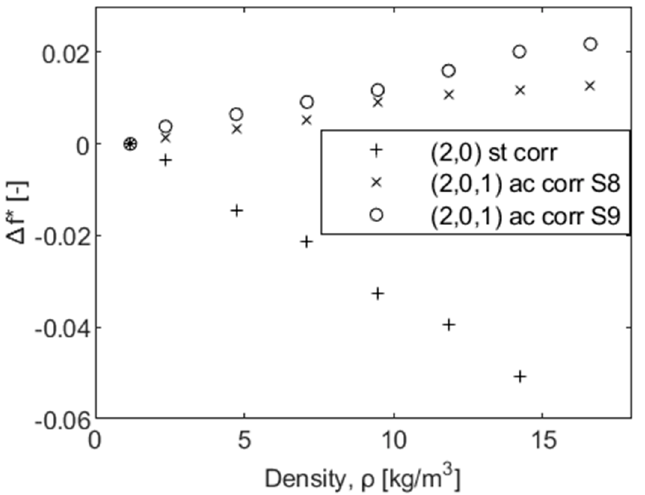
Figure 7. Corrected relative frequency changes of two nodal diameter mode pair in air for “slim cavity” over fluid density. Values corrected for added mass effect and speed of sound effect, respectively. Sensors: S8 on disk, S9 in front cavity.